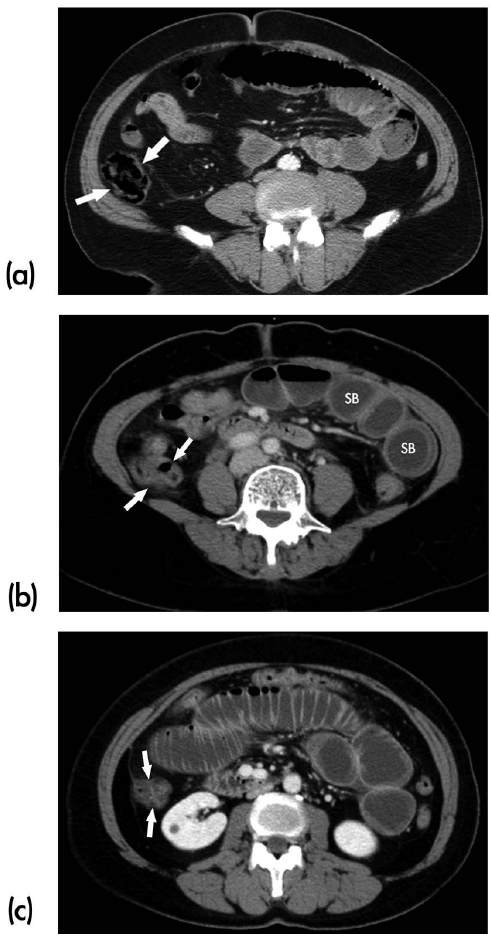
Figure 1. Three degrees of SBO defined by MDCT images. (a) ‘‘Low-grade partial’’ SBO. Note the moderate amount of gas and faeces in the ascending colon (arrows). (b) ‘‘ High-grade partial’’ SBO. Note the small amount of gas and fluid in the ascending colon (arrows). There is no evidence of small bowel wall thickening or ischemia. The maximal diameter of the obstructed fluid-filled small bowel (SB) is measured larger than 3.0 centimeter. (c) ‘‘Complete’’ SBO. Note the complete collapse of the ascending colon (arrows) with no appreciable gas or fluid.